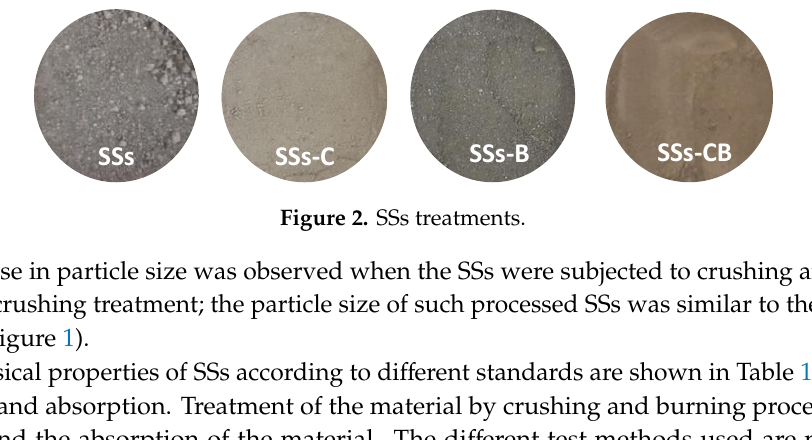
Figure 2. SSs treatments.